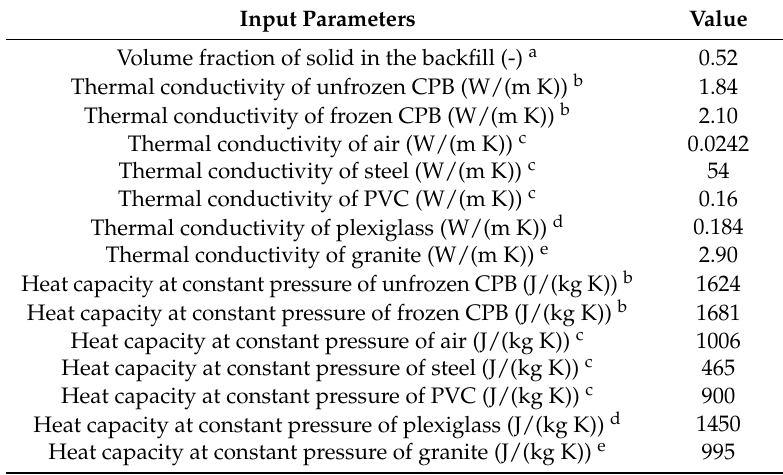
Table 4. Input parameters for numerical modeling